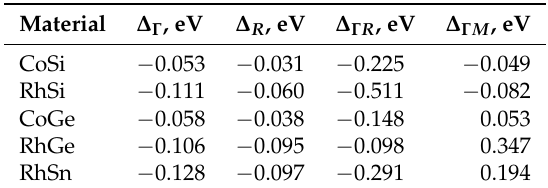
Figure 10. Band structure and surface Fermi arcs in RhSn. Table 3. Evolution of energy differences for semimetallic monosilicides and monogermanides of Co and Rh, and for RhSn crystallizing in B20 structure. ∆ Γ is SOC splitting of two- and fourfold degenerate nodes at Γ point. ∆ R is the SOC splitting of the two- and sixfold degenerate nodes at R point. ∆ Γ R is energy distance between sixfold degenerate node at R point and fourfold degenerate node at Γ point. ∆ Γ M is energy difference between valence band maximum at M point and fourfold degenerate node at Γ